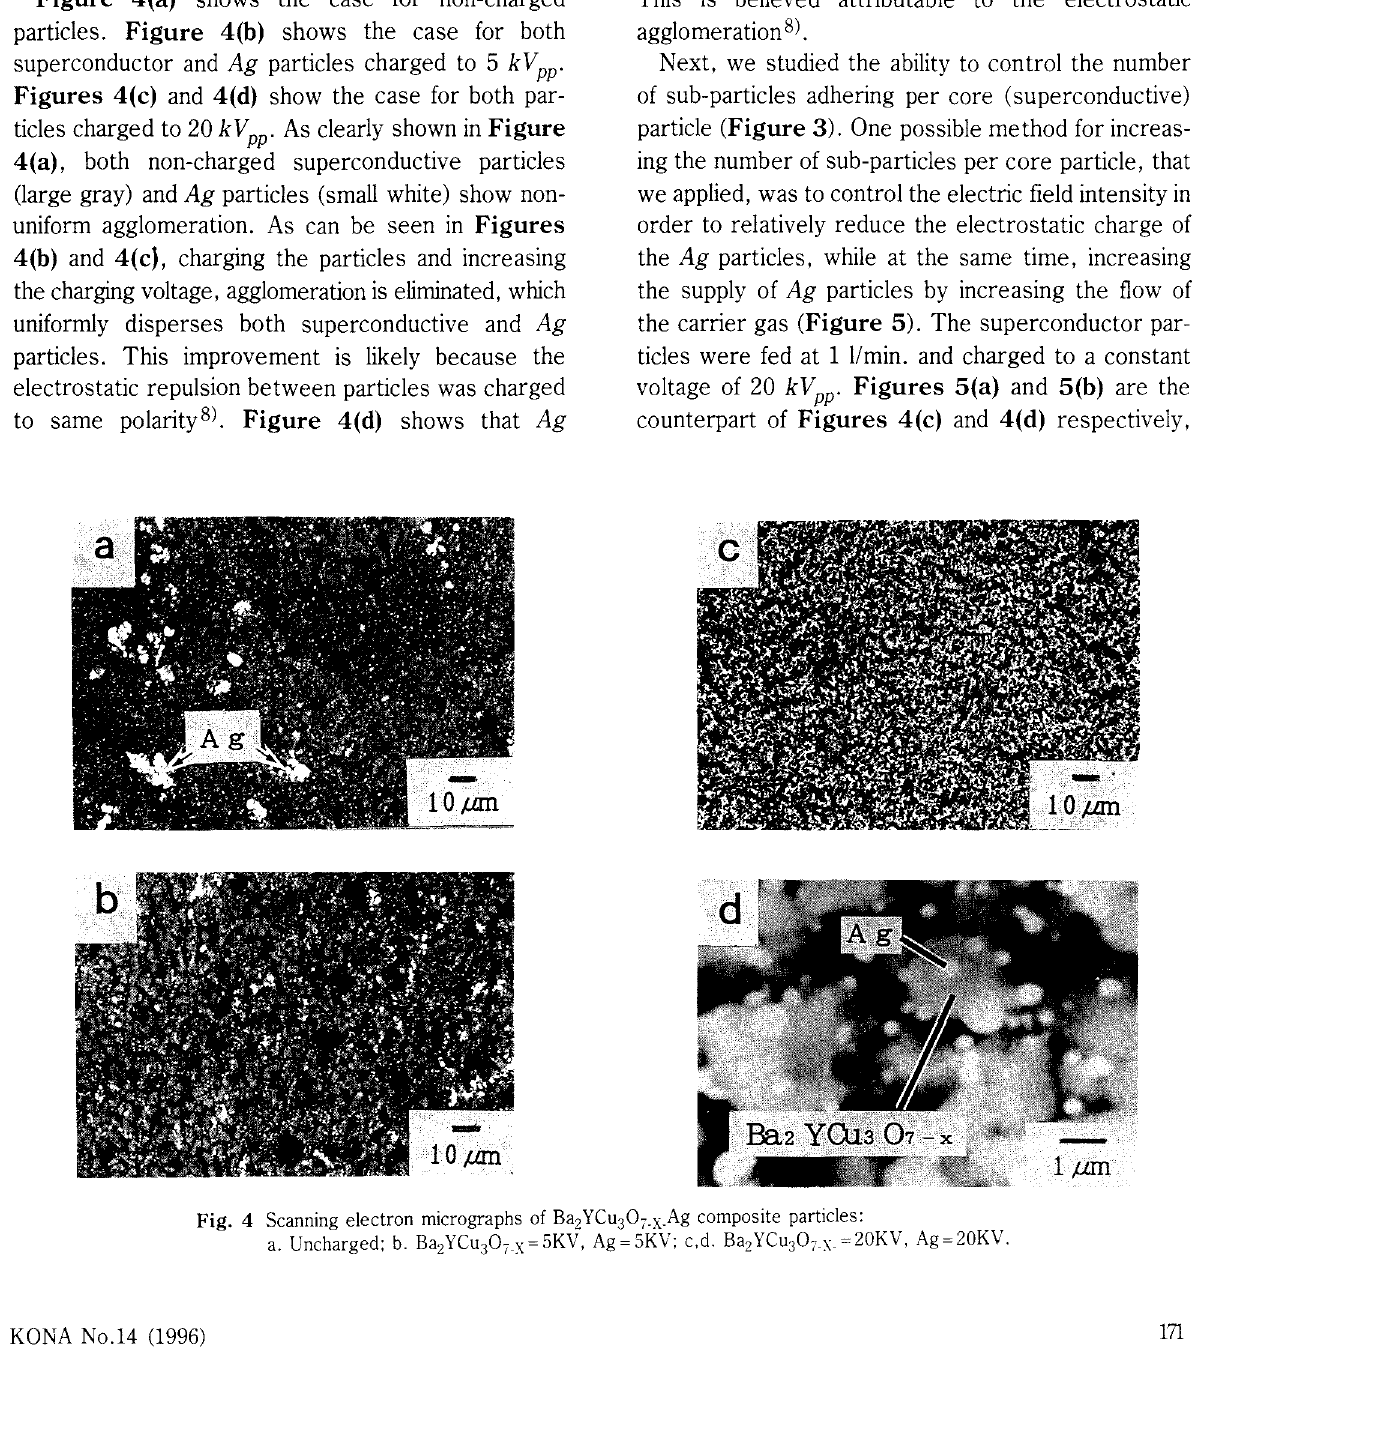
Fig. 3 Scheme of development of oxide superconductive composite using conventional process, and aerosol process the sub-component particles.